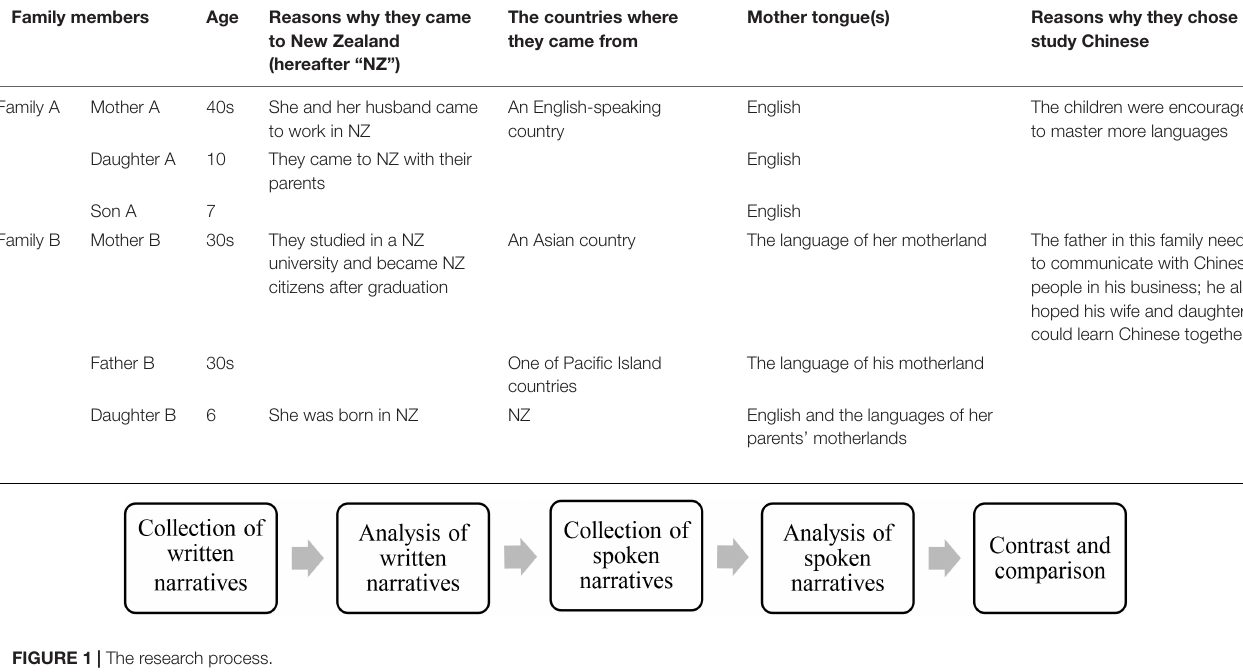
TABLE 1 | Information about the two families.